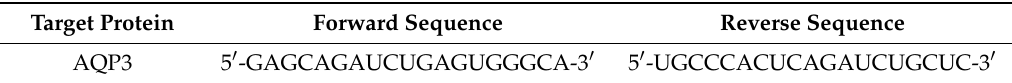
Table 2. Sequences of siRNA